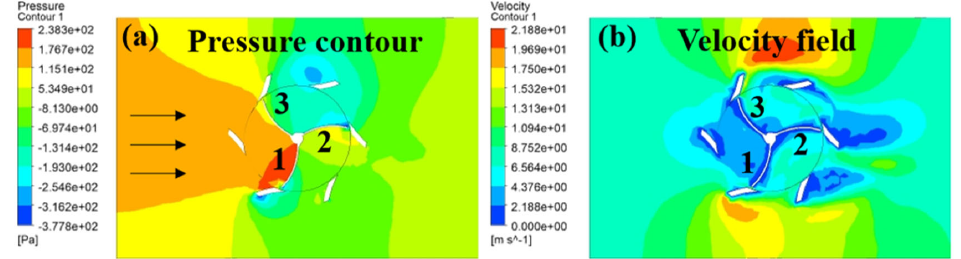
Figure 6. The dynamic analysis of the wind capture device: ( a ) pressure contour; ( b ) velocity field.